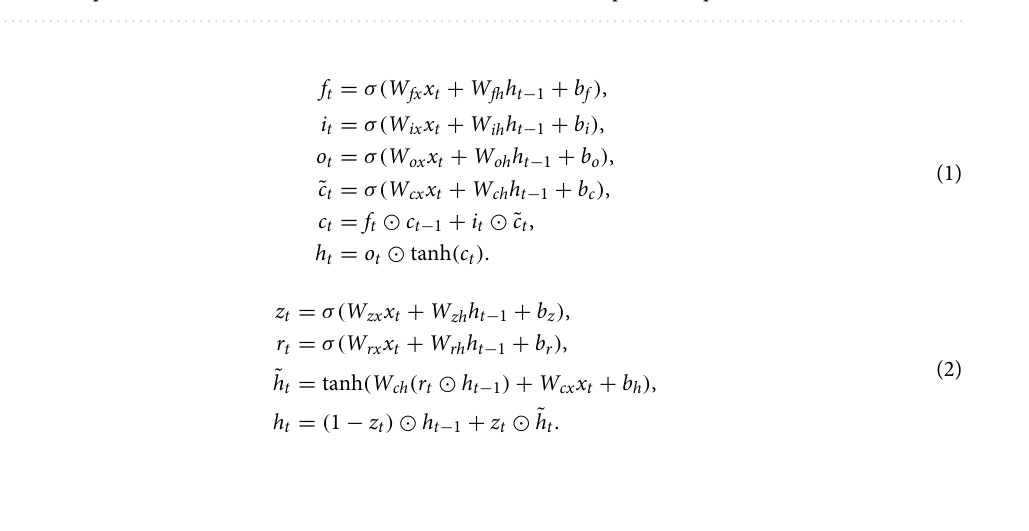
Table 4. Temporal models. The CNN model structures to learn the temporal